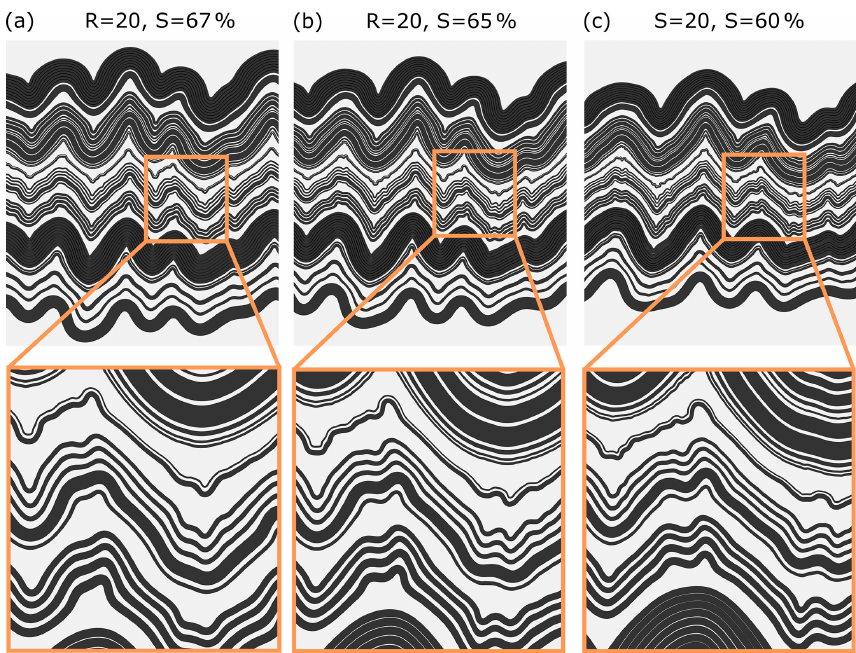
Figure 15. (a–c) Models showing the role of initial normalised perturbation amplitude for A pert /h ref = 0.045, 0.15, and 0.45, respectively. In all models, the viscosity ratio between the dark and white layers is set to R =